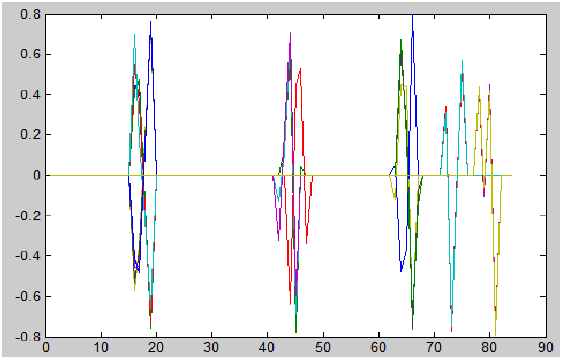
Figure 21. Representation of 20 sensors (“weak classifiers”) with small supports. They were obtained as shown in Section 6.1. The x-axis represents the wavelengths index and the y-axis represents the values of the